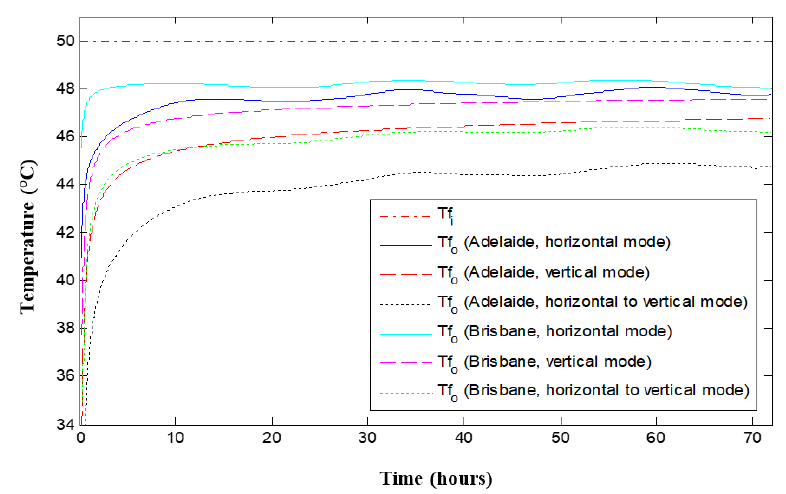
Figure 15. Profile of fluid temperatures of the horizontal, vertical, and the horizontal to vertical modes under different climate conditions.